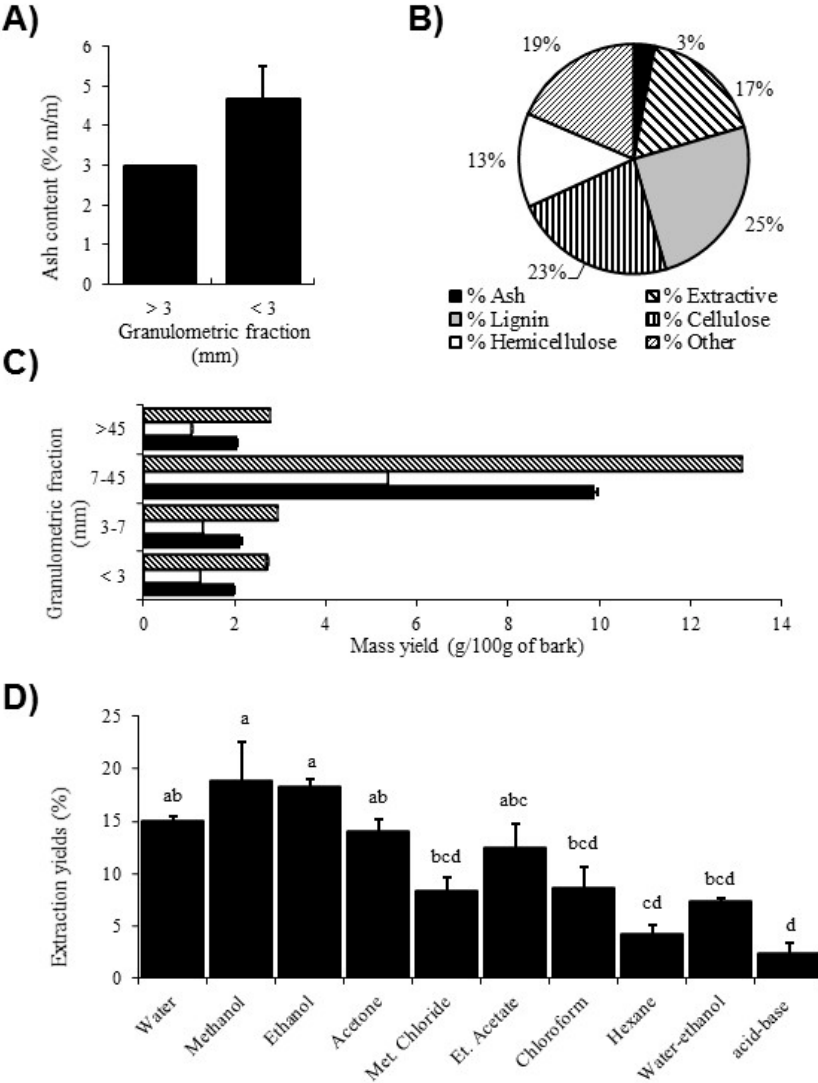
Figure 1. Evaluation of Quaking Aspen bark composition and yield according to different extraction parameters. ( A ) Ash content (% m/m) of bark according to the granulometric fraction <3 mm or >3 mm; ( B ) Quaking aspen bark relative composition of extractives, ash and lignocellulosic materials (% m/m); ( C ) Extraction yields of quaking aspen bark under different granulometric conditions and with different extraction solvents; ( D ) Mass yield (% of total dry mass) of quaking aspen bark according to different extraction solvents. In graph, columns identified with different letters (a–d) are significantly different using one-way analysis of variance (ANOVA) followed by pairwise mean comparison Tukey’s test where differences were detected ( n = 3, p < 0.05).